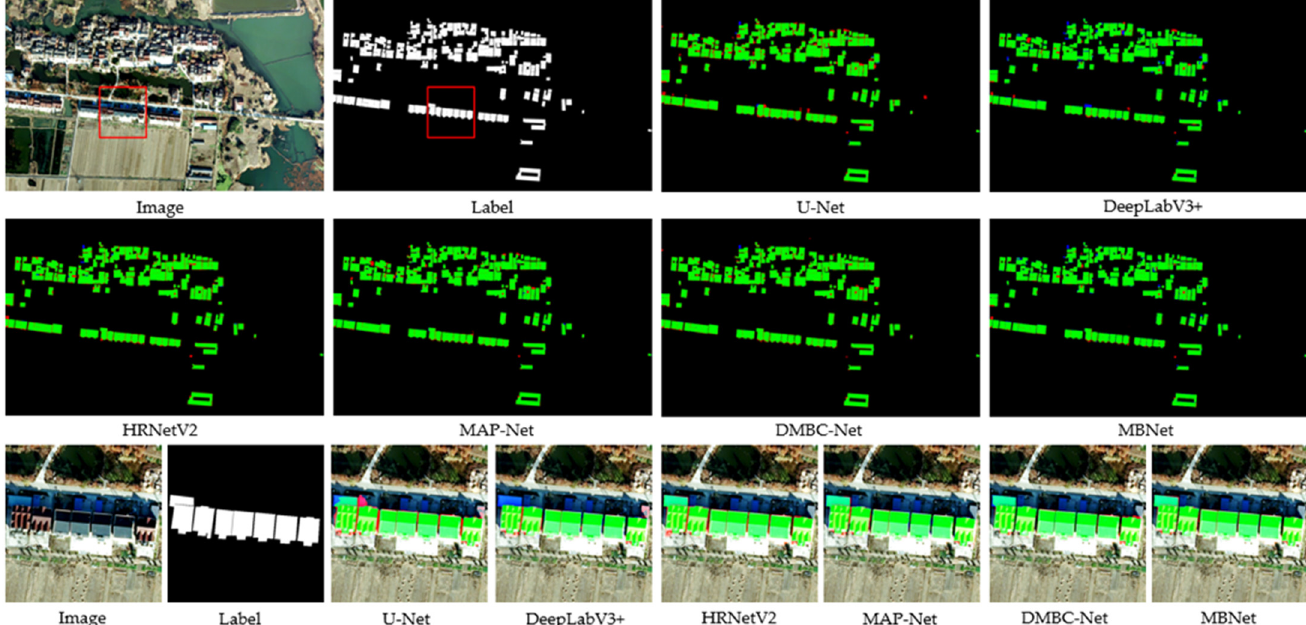
Figure 14. Segmentation results of the different SOTA methods on the hilly landform scene 3 test dataset. The bottom row is a close-up view of the red box.